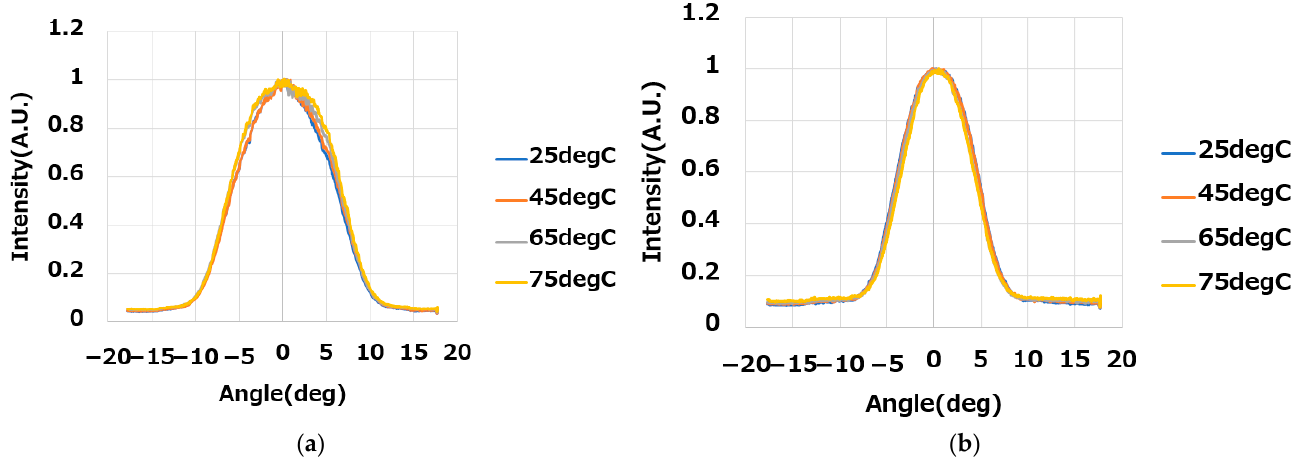
Figure 11. Far-field pattern of the SS-VCSEL on the Tx module at different temperatures under ( a ) one-block and ( b ) all-blocks emissions.